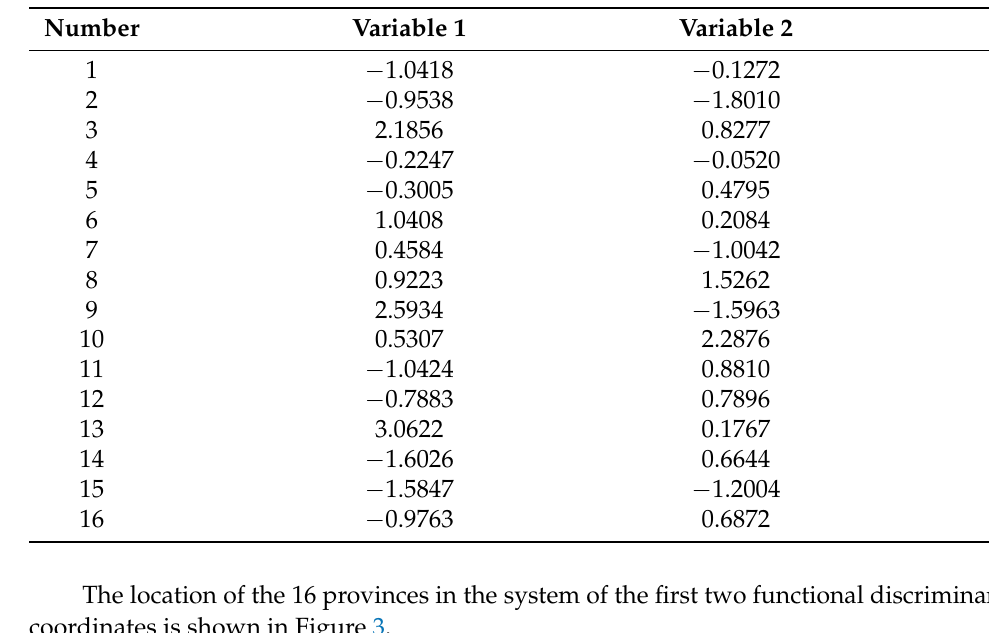
Table 4. The mean values of the 16 provinces (first two).